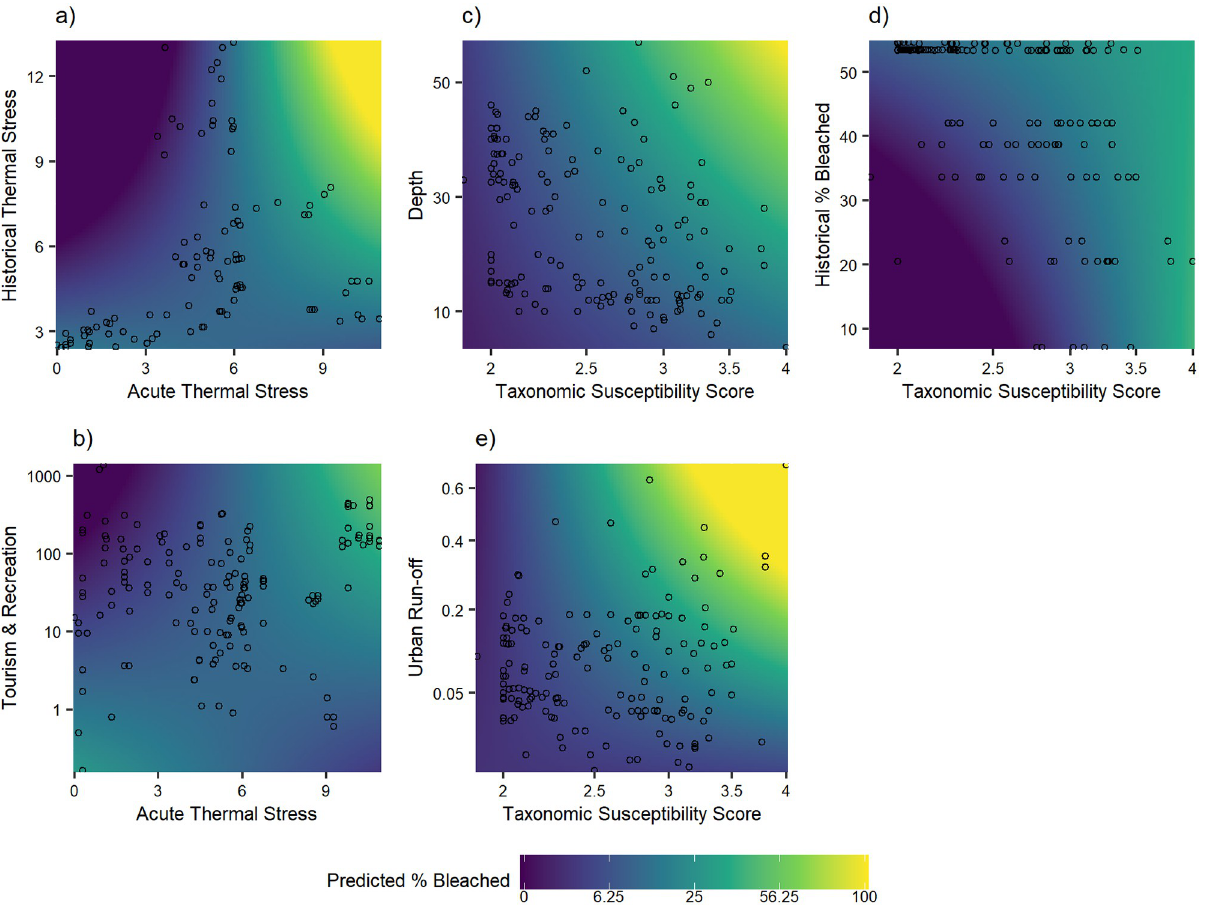
Fig 7. Prediction interaction surface plots. Gradient denotes predicted percent bleached from best-fit model across ranges of (a) acute thermal stress (DHW) and historical thermal stress (DHW), (b) acute thermal stress (DHW) and tourism/recreation, (c) susceptibility and depth (ft), (d) susceptibility and historic percent bleached, and (e) susceptibility and urban run-off. Model predictions were generated per interaction effect by holding all other variables at their mean value. Points denote observed values of variables. See S8 Table for variable